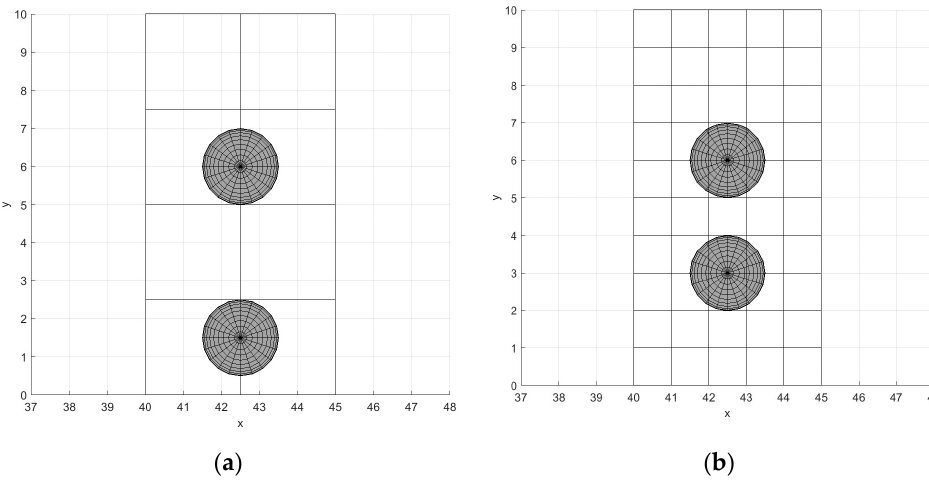
Figure 12. Top view of the intersection showing the minimum distance between UAVs on different cube sizes. ( a ) Size of a cube is 2.5 m. ( b ) Size of a cube is 1 m.